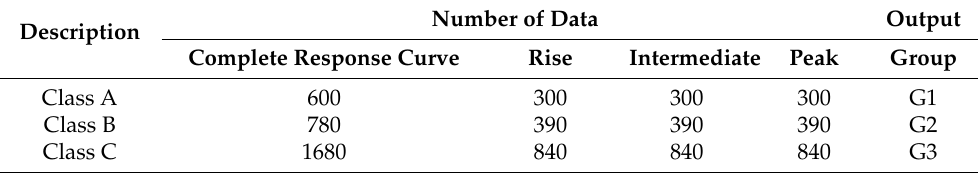
Table 4. Size of the training dataset for each of the 13 measurement sensors, at different extracted signals, by using linear discriminant analysis (LDA).